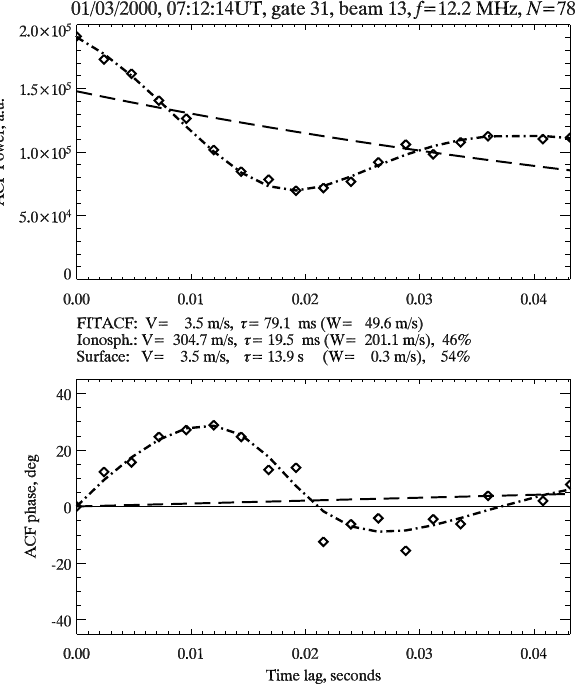
Fig. 2. Mixed-scatter ACF power, | R(τ) | [top], and phase, 9(τ) [bottom]. Experimental data are shown by open diamonds, dashed lines represent results of FITACF conventional fitting procedure, and dash-dot lines correspond to two-component fitting as defined by Eq.